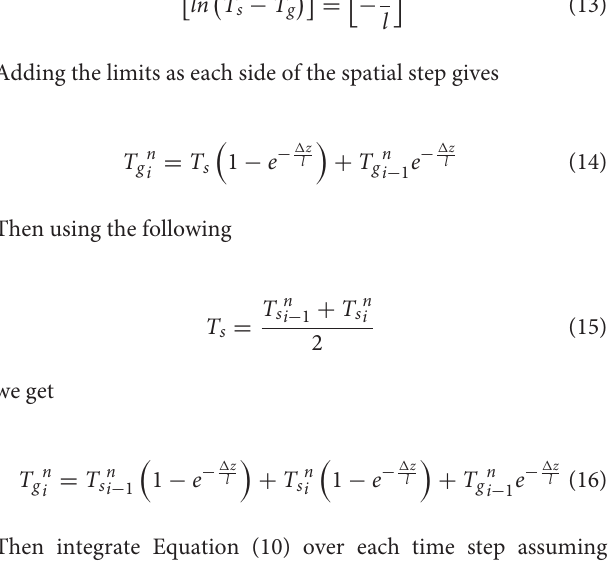
(9) over a spatial step assuming T s is constant across that step